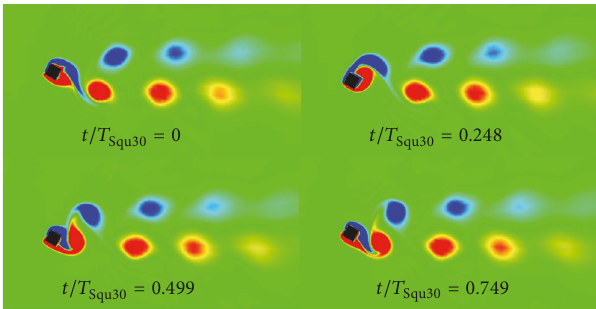
Figure 19: Vortex structures in synchronization region for 𝛼 = 30 ∘ / 𝛼 = 60 ∘ .